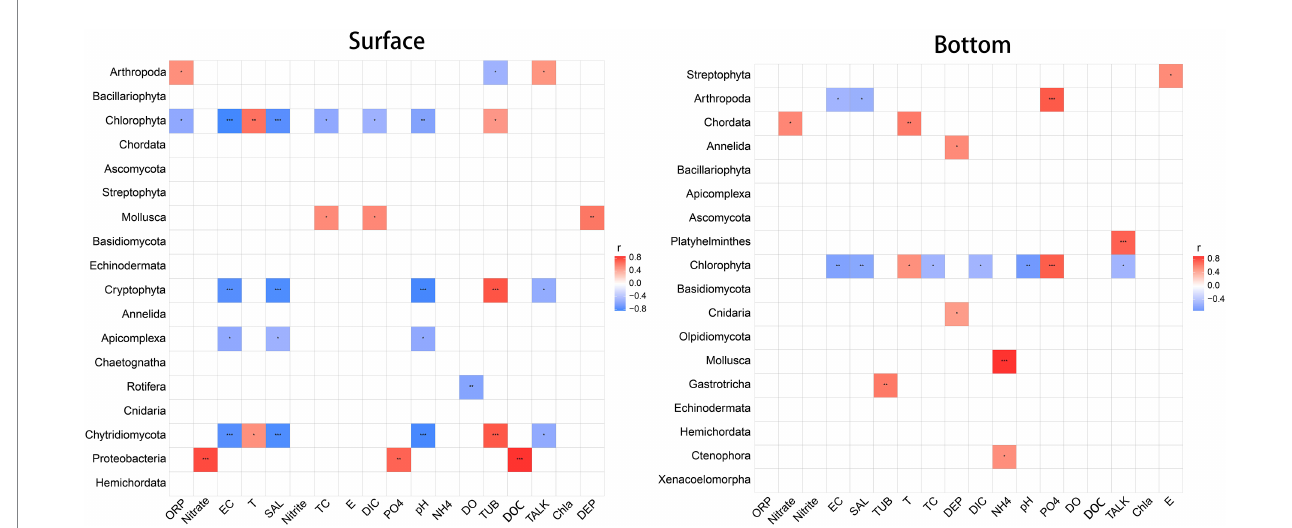
FIGURE 5 Spearman correlation between biological community and environmental variables. Red indicates positive correlation, while blue indicates negative correlation. * p < 0.05, ** p < 0.01, *** p <